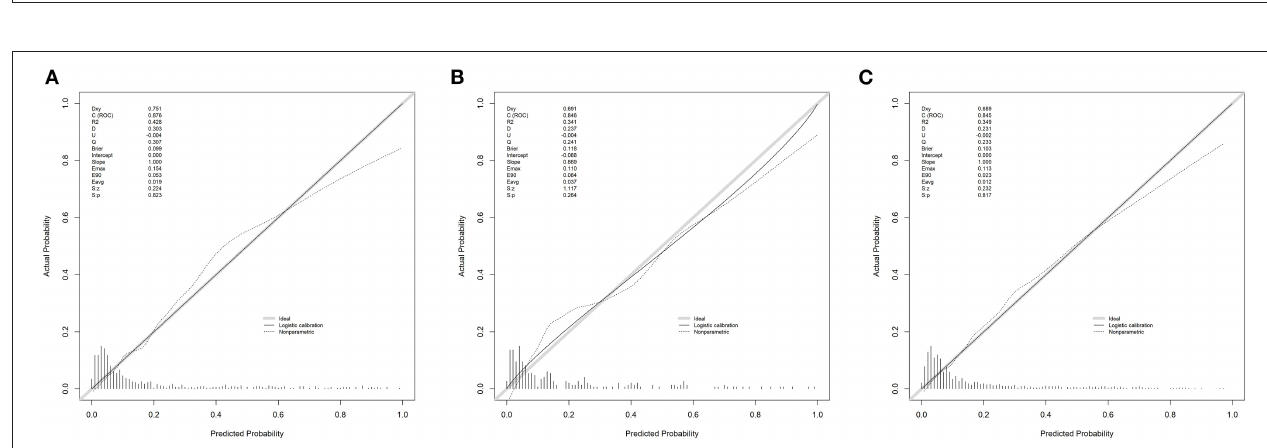
FIGURE 4 | Calibration curves. Calibration curves depict the calibration of the newly established nomogram in terms of the agreement between the predicted probabilities and observed frequencies of the training cohort (A) , validation cohort (B) , and MIMIC-IV cohort (C) .